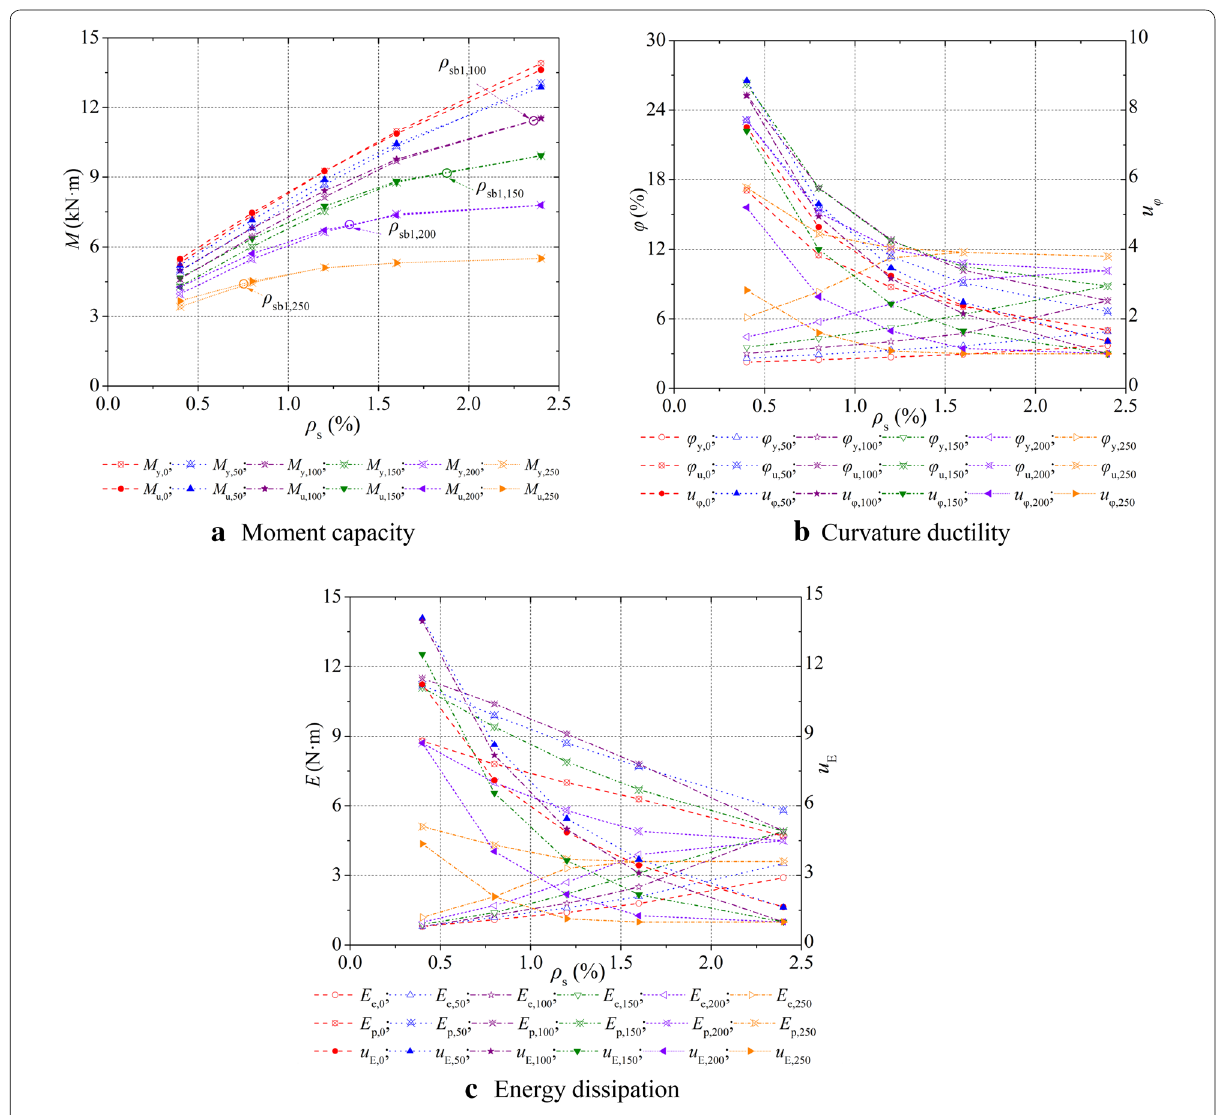
Fig. 14 Influence of ECC height replacement ratio on moment capacity, curvature ductility and energy